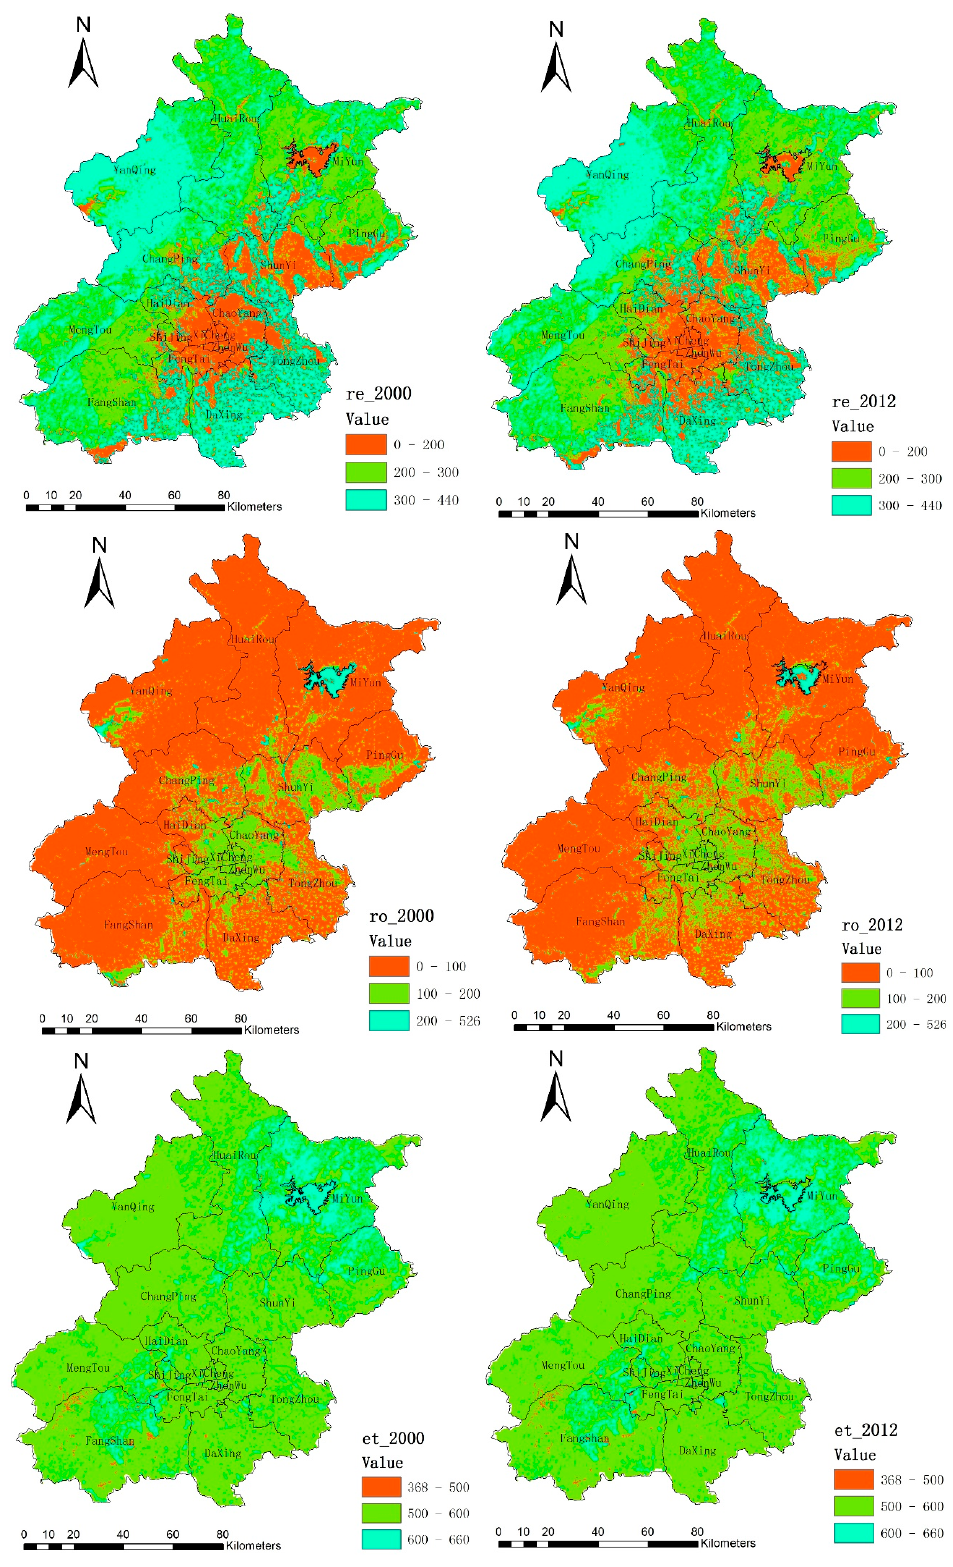
Figure 5. The water balance of 2000 and 2012 (re_2000, ro_2000 and et_2000 are groundwater recharge, surface runoff, and actual evapotranspiration for 2000, respectively; and re_2012, ro_2012 and et_2012 are groundwater recharge, surface runoff, and actual evapotranspiration for 2012, respectively). The variation in land-use types from 2000 to 2012 were considered as the main influencing factor to spatial differences of water balance components. To assess these influences, we compared the average annual recharge, surface runoff, and actual evapotranspiration for different land use types. The relationships between land use types and water balance components were relatively steady and existed little difference in the same area with short time interval. Figure 6 presents the water balance components as a result of different land cover types in 2000. Overall, the “high–low” sequence of recharge is bare land, grassland, shrub, agricultural land, and built-up land, successively. Furthermore, built-up land has the lowest groundwater recharge, except rivers and lakes, as the recharge from precipitation is very insignificant, and it has a relatively high surface runoff due to the ground with less roughness and higher impervious rates. As for forests, grasslands, and shrubs, they are characterized by a higher evapotranspiration and recharge when the runoff is reduced. In addition, the agricultural land and bare land have more ground-level low roughness ground-level, which leads to increased runoff and decreased evapotranspiration compared with built-up land.